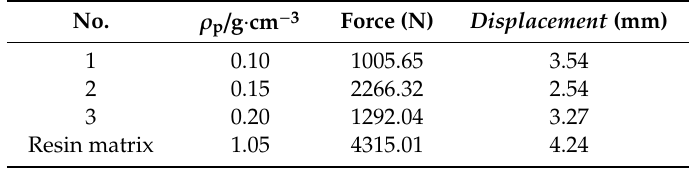
Figure 2. Mechanical curves of polyurethane composites and resin matrix. Table 5. Mechanical properties of polyurethane resin matrix and